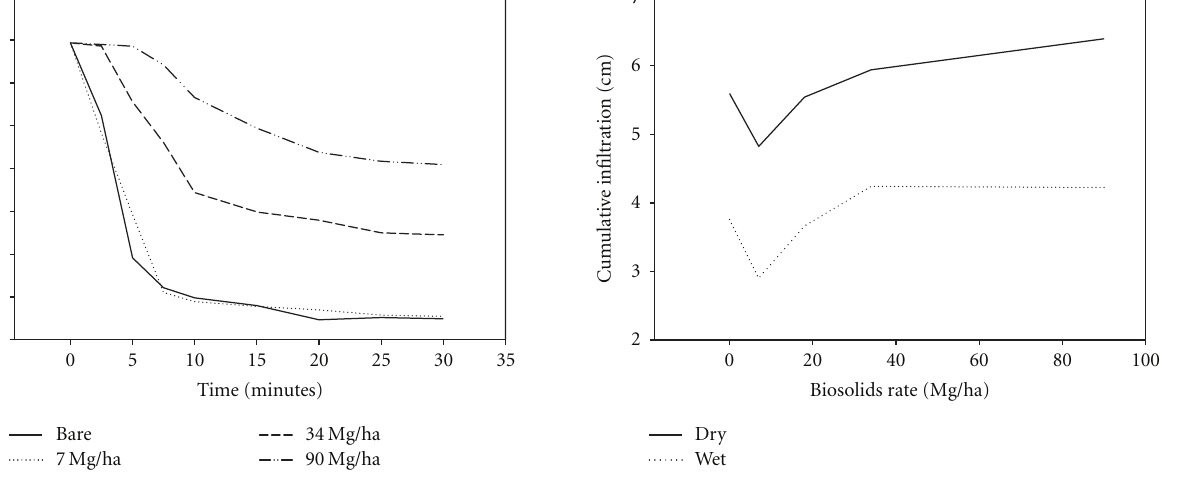
Figure 6: Infiltration flux as a function of time and rate of biosolids applied on a Chilicotal soil with a gravelly surface on the Sierra Blanca Ranch.